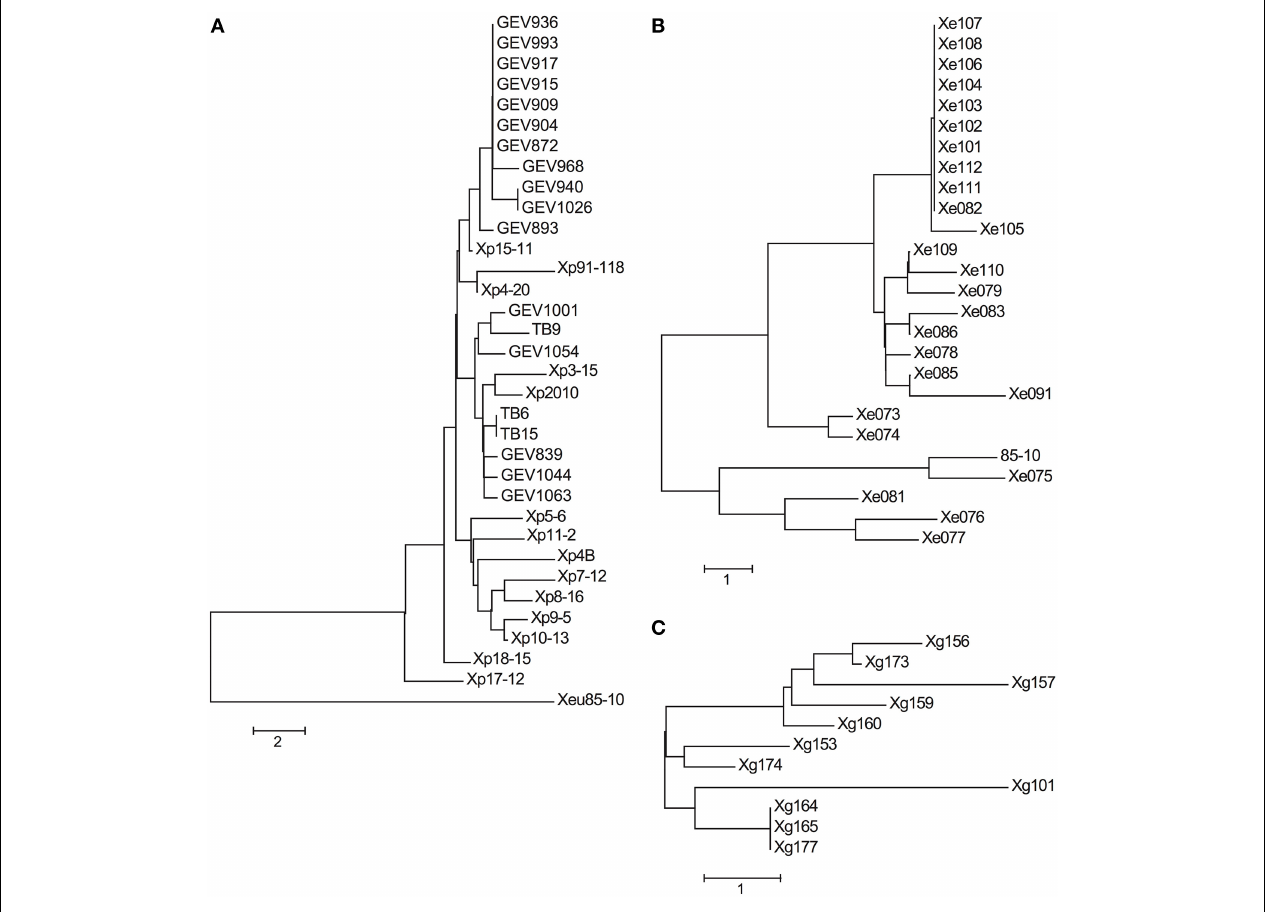
FIGURE 3 | Neighbor-joining trees of effector allele profiles. Neighbor-joining trees for Xp (A) , Xe (B) , and Xg (C) field strains were constructed using nucleotide ( Xe and Xg ) and amino acid ( Xp ) pairwise allele